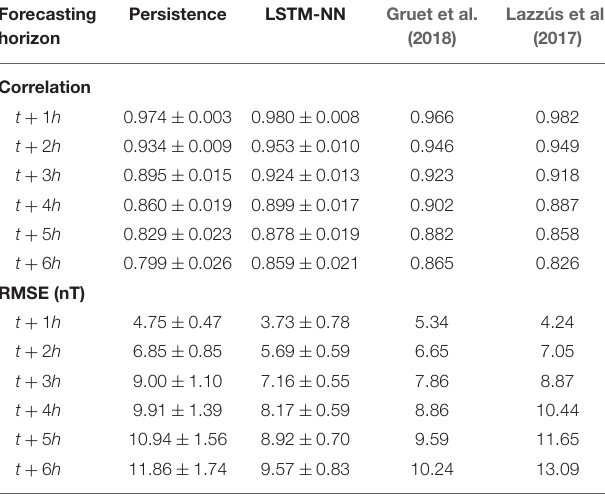
TABLE 2 | The RMSE and Pearson linear correlation coefficient of the persistence model and LSTM-NN model compared to the models of Gruet et al. (2018) and Lazzús et al.